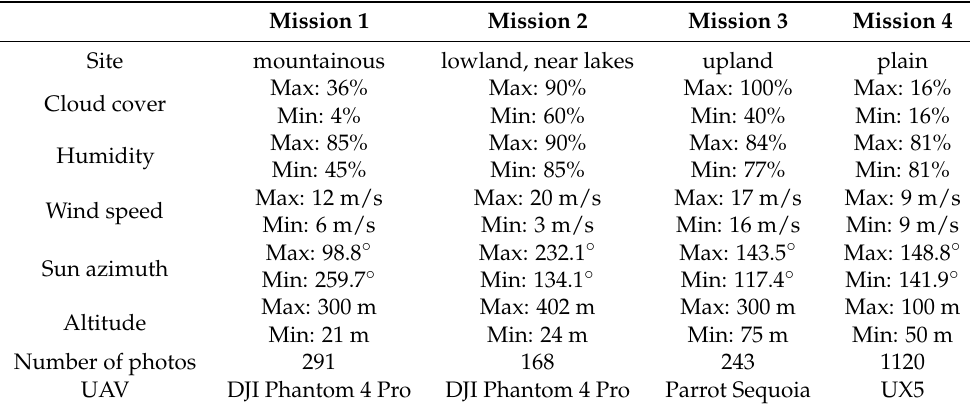
Table 1. Summary of parameters of the photogrammetric